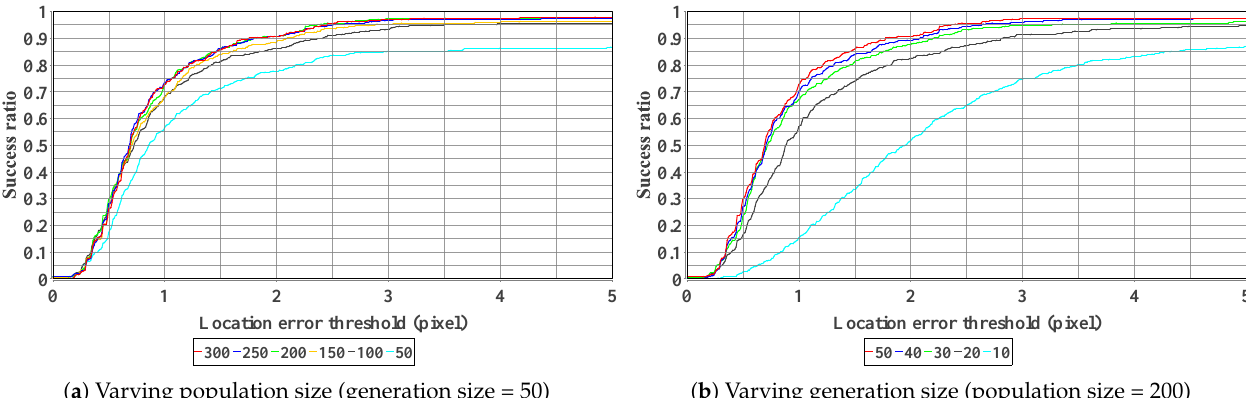
Figure 6. Curves show the average success ratio of 10 trials with different parameter settings. All the test images are used for plotting. The curve closer to the top left represents better performance. Best view in